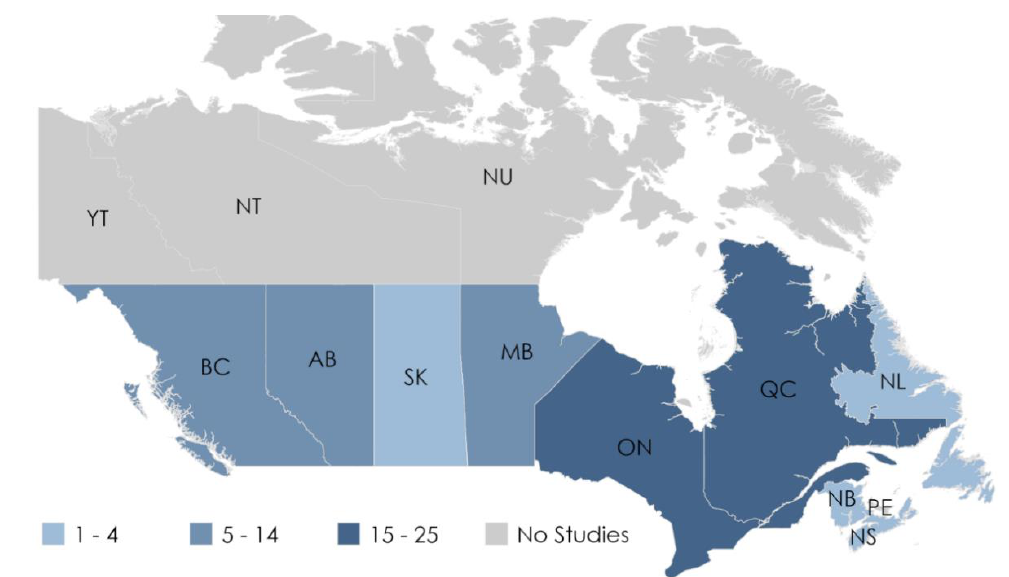
Figure 2. The frequency populations from each province were represented in the studies. A number of studies were specifically focused on populations in Ontario (20), Quebec (15), British Columbia (9), and Alberta (2), while the remaining studies included specific populations from multiple provinces.